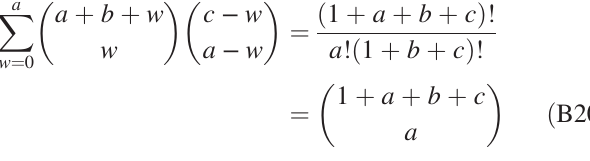
ffiffiffiffiffiffiffiffiffiffiffiffiffiffiffiffi p 2 j þ 1 B